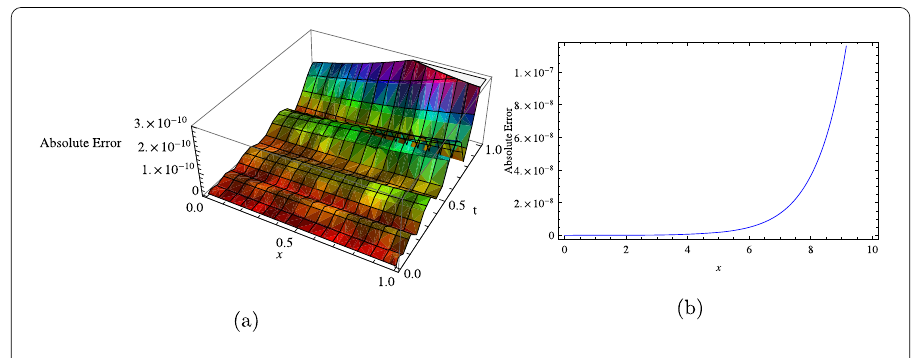
Figure 5 Plot of the absolute error of TFNWS equation when (cid:2) = –0.8. ( a ) E 4 ( η ) = | η ( x , t ) – η 4 ( x , t ) | . ( b ) The